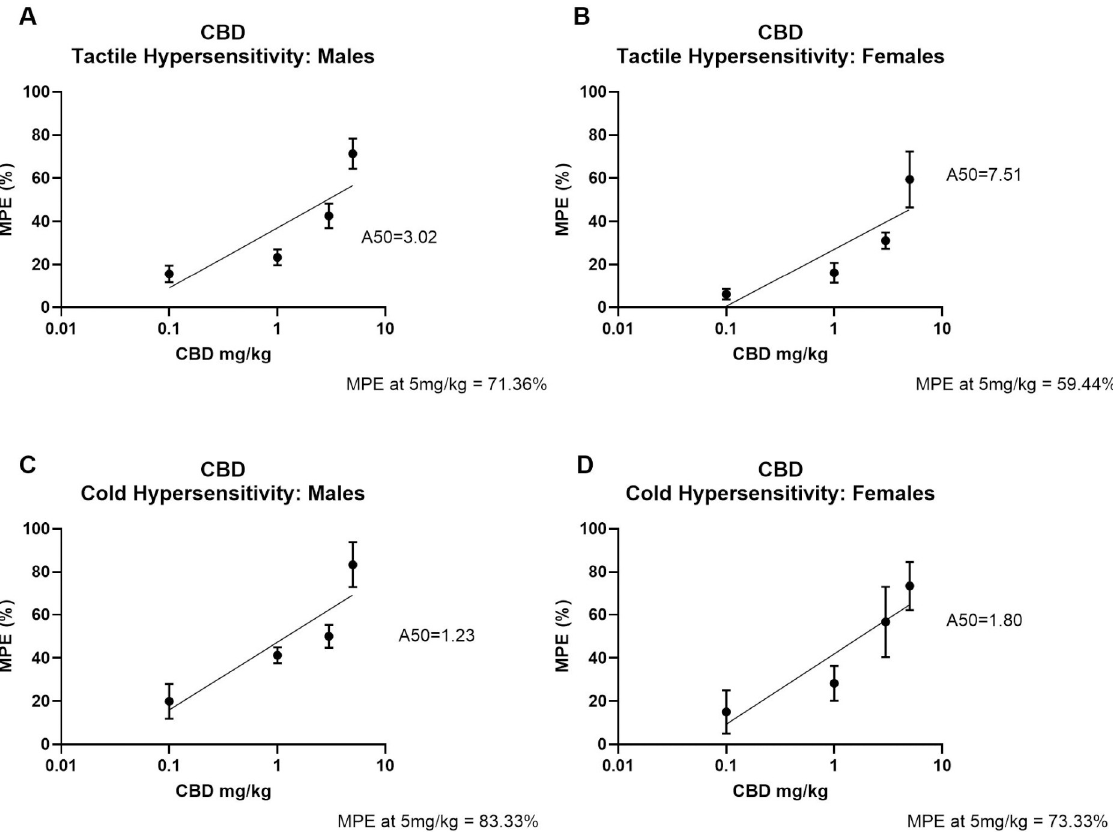
Fig 2. Dose response curves for CBD antinociceptive effects in male and female rats. Dose response curves for the effect of CBD on mechanical paw withdrawal threshold in A) males and B) females and acetone responses in C) males and D) females. A50 for each treatment group is displayed. MPE for the highest dose of CBD is indicated as well. Data are shown as % maximal possible effect (% MPE) ±